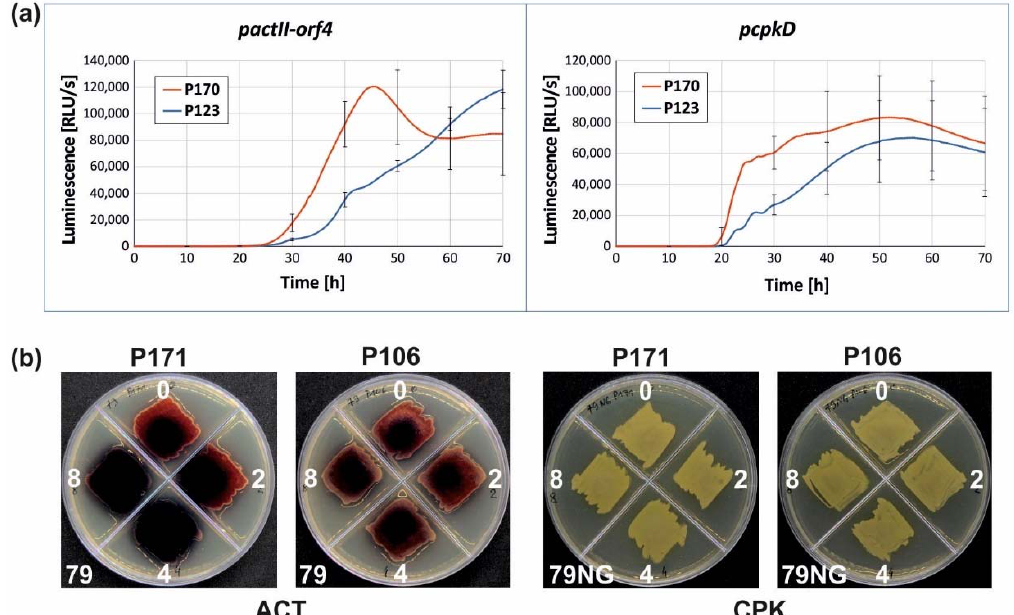
Figure 6. Effects of SCO3932 overexpression. ( a ) Activity of cpkD and actII-orf4 promoters measured in the luciferase reporter assay, P170—strain overexpressing SCO3932, P123—control strain, standard deviation was shown for every 10 h time-point for clarity; ( b ) Phenotypic effects of SCO3932 overexpression induced by thiostrepton in the concentration 0, 2, 4, 8 μ g/mL (as indicated) on 79 and 79NG media, P171—strain overexpressing SCO3932, P106—control strain.